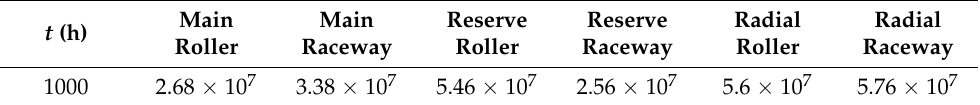
Figure 4. Curve of cyclic load Q with time. Table 2. The relation between the number of load cycles of roller raceway and the working time. t